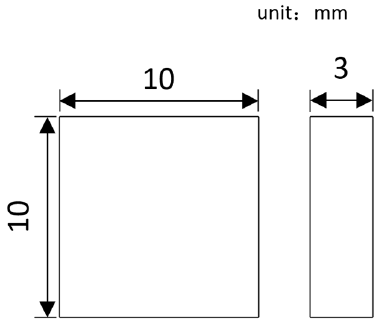
Figure 2. The dimensions of the S32750 SDSS samples for exposure.